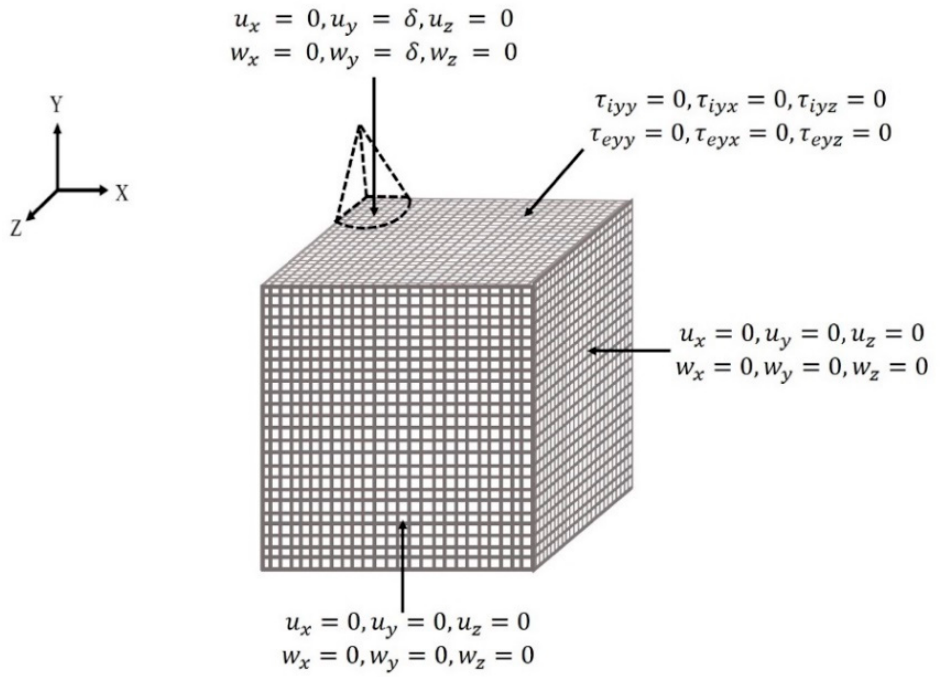
Figure 3. Due to the symmetry, an octant of the tissue was considered for the analysis as shown in the figure. The origin of the coordinate grid is located at the center of the cube (the bottom, back, left corner of the octant shown). The three surfaces shown in the figure are X = 1, Y = 1 and Z = 1. Indentation occurs at the top surface of the tissue ( Y = 1). At the Y = 1 surface, everywhere except the tissue under the indenter is considered as a free boundary. By assuming an infinite tissue, or by assuming that the X =1 and Z = 1 surfaces are attached to a rigid box, the displacements at the X = 1 and Z = 1 surfaces become